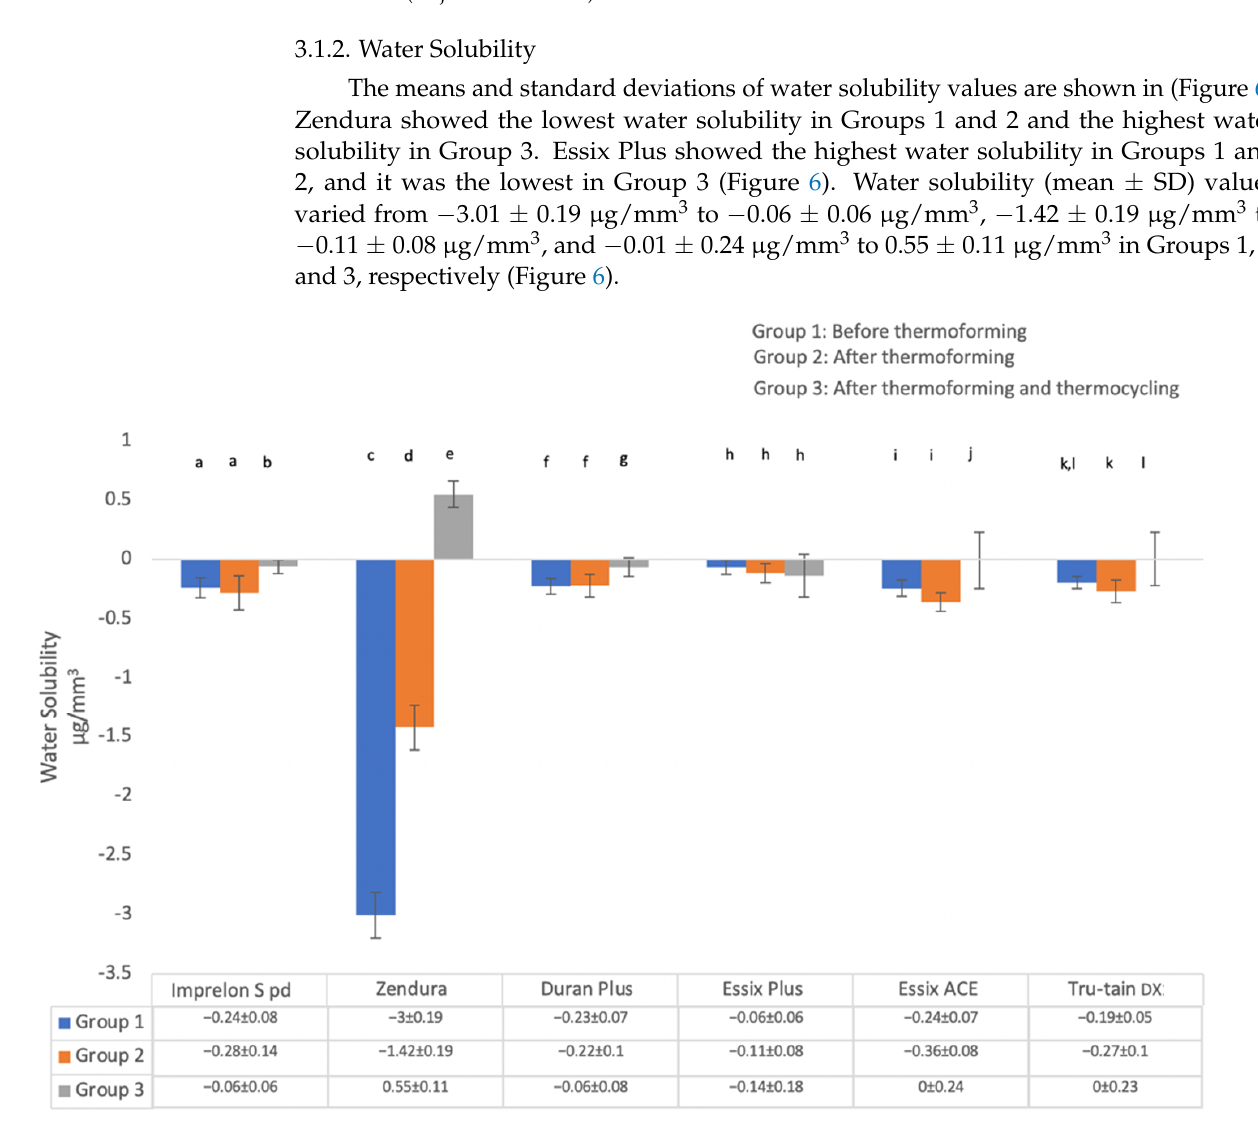
Table 3. Two-way ANOVA (Tests of Between-Subjects Effects).